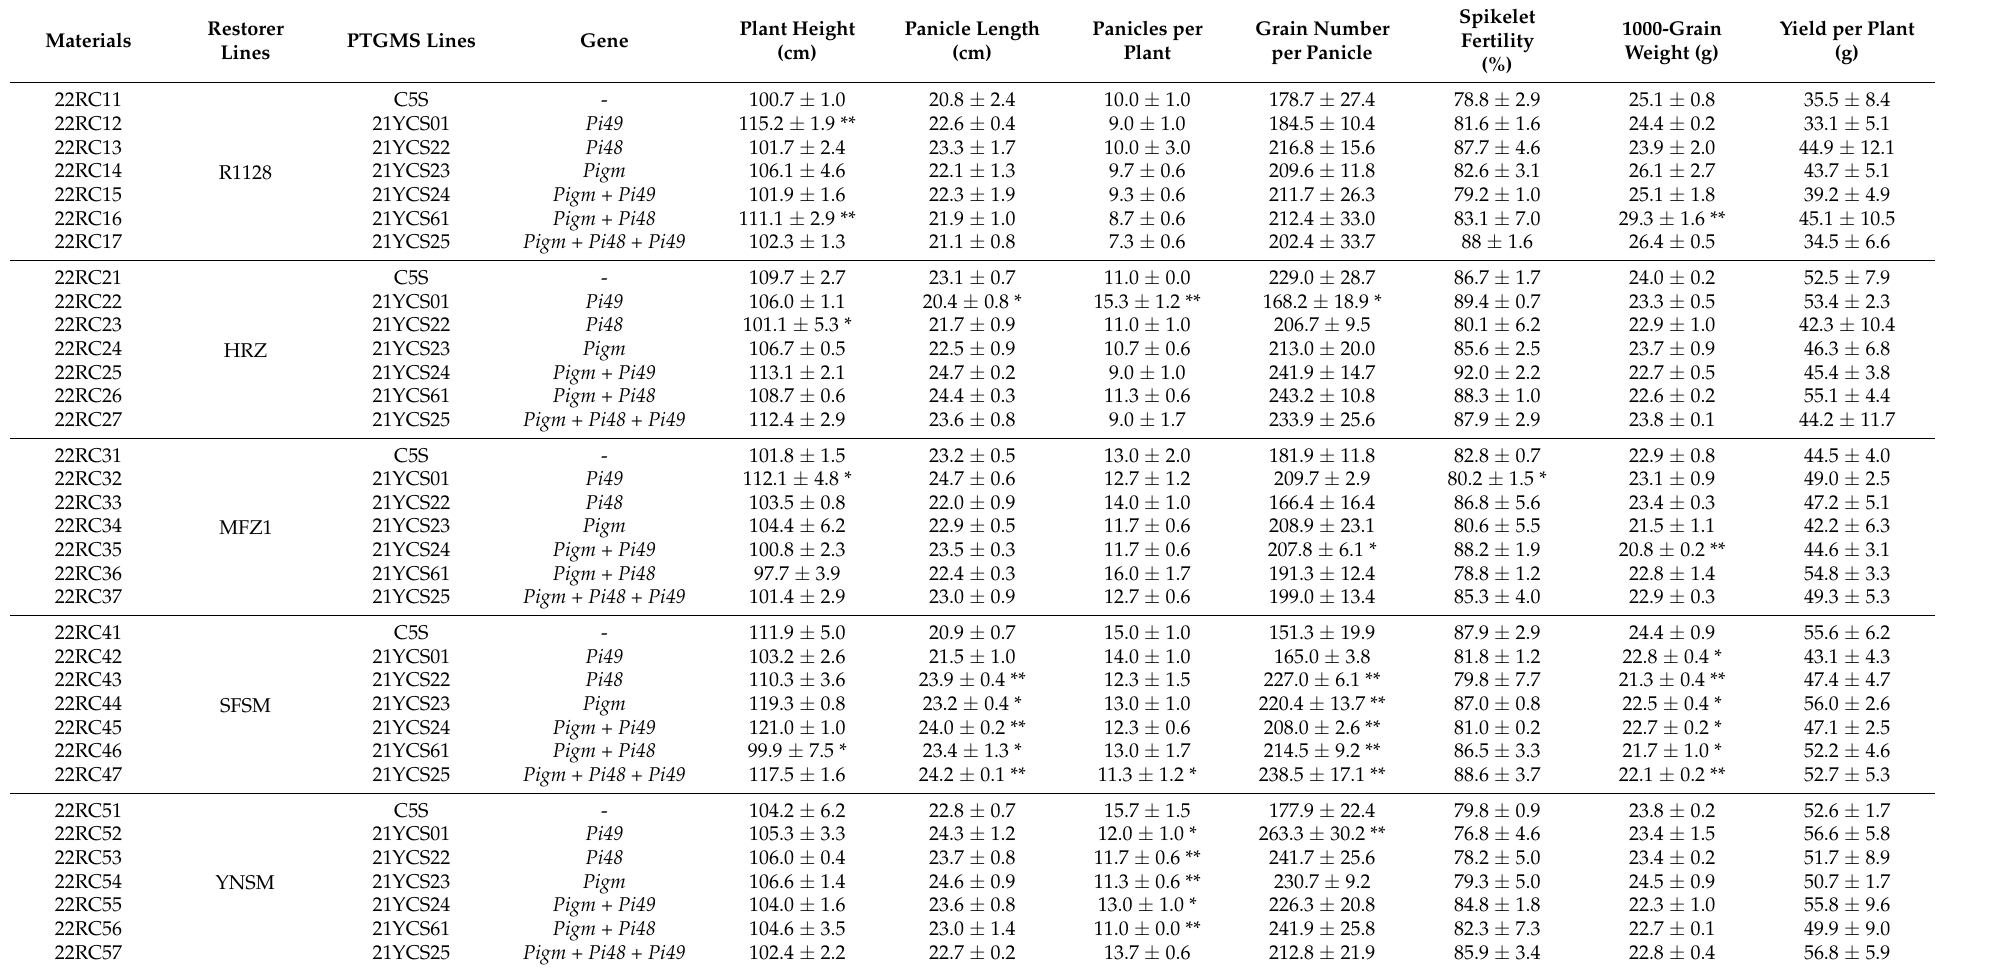
Table 4. Agronomic traits of the hybrids of C5S and the improved